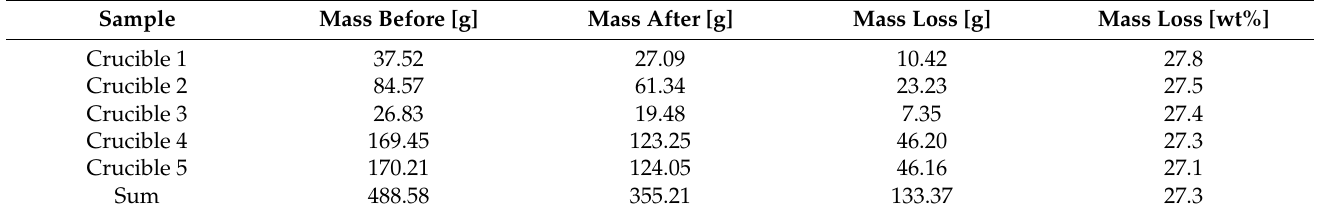
Table 3. Mass data and mass losses in calcination of the raw PMMN ore.